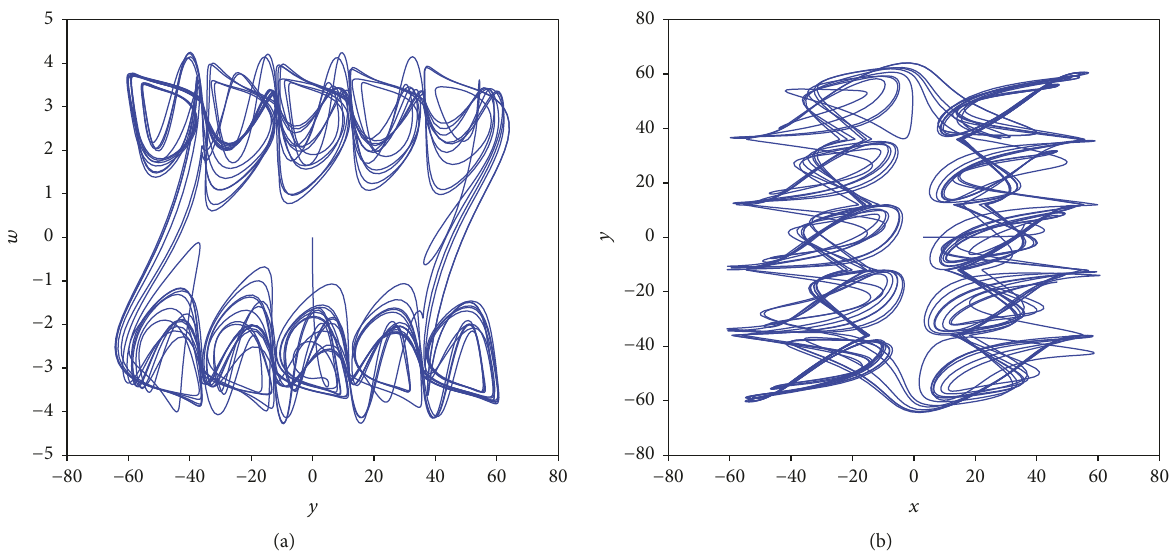
Figure 6: Projections of the 2 × 5 multiscroll hyperchaotic attractors onto the y , w and x , y plane. (a) y , w plane. (b) x , y plane.